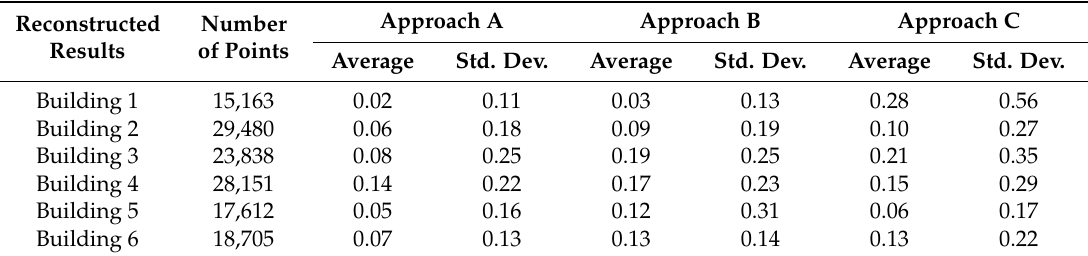
Table 6. Comparison of deviation distances for Buildings 1–6 reconstructed by Approaches A, B, and C.